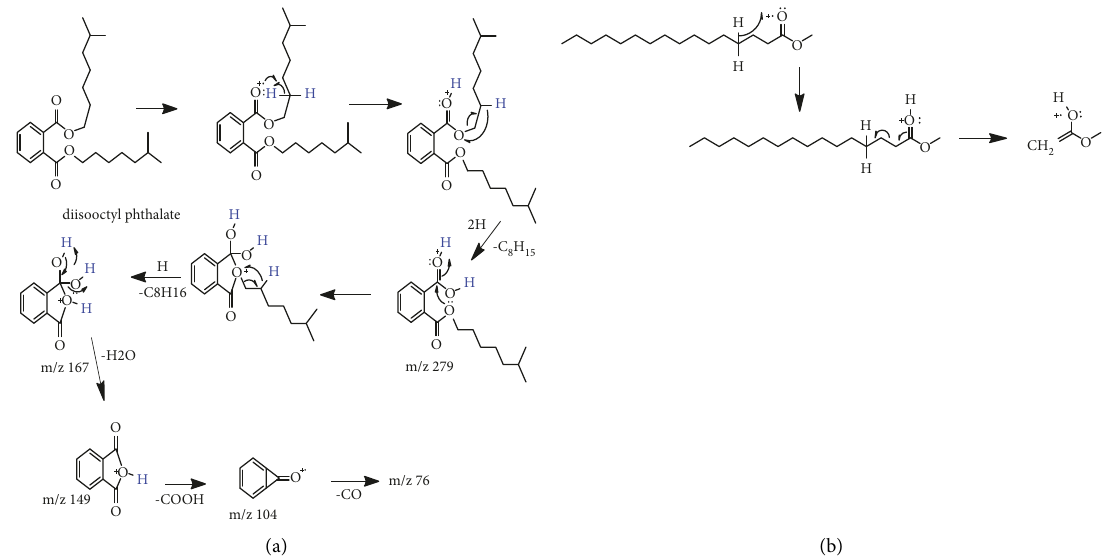
Figure 8: MS fragmentation of diisooctyl phthalate (a) and the McLafferty rearrangement in hexadecenoic acid methyl ester (b).